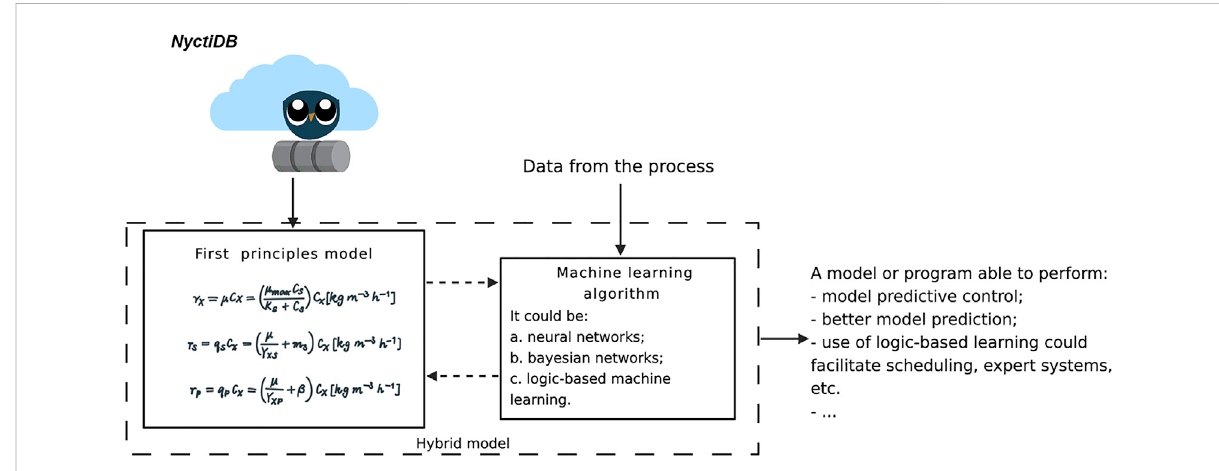
FIGURE 7 NyctiDB as fi rst principles models provider for hybrid modeling. Based on Nielsen et al.